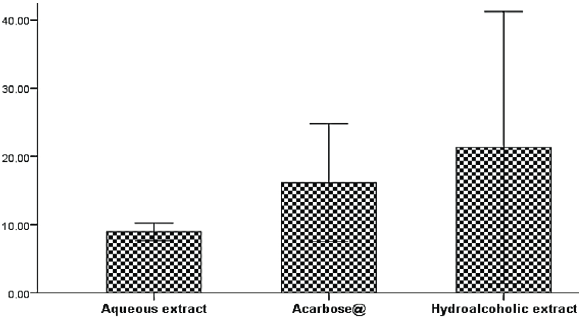
, mg/mL Figure 2 Inhibition of glucose uptake by yeast, IC 50